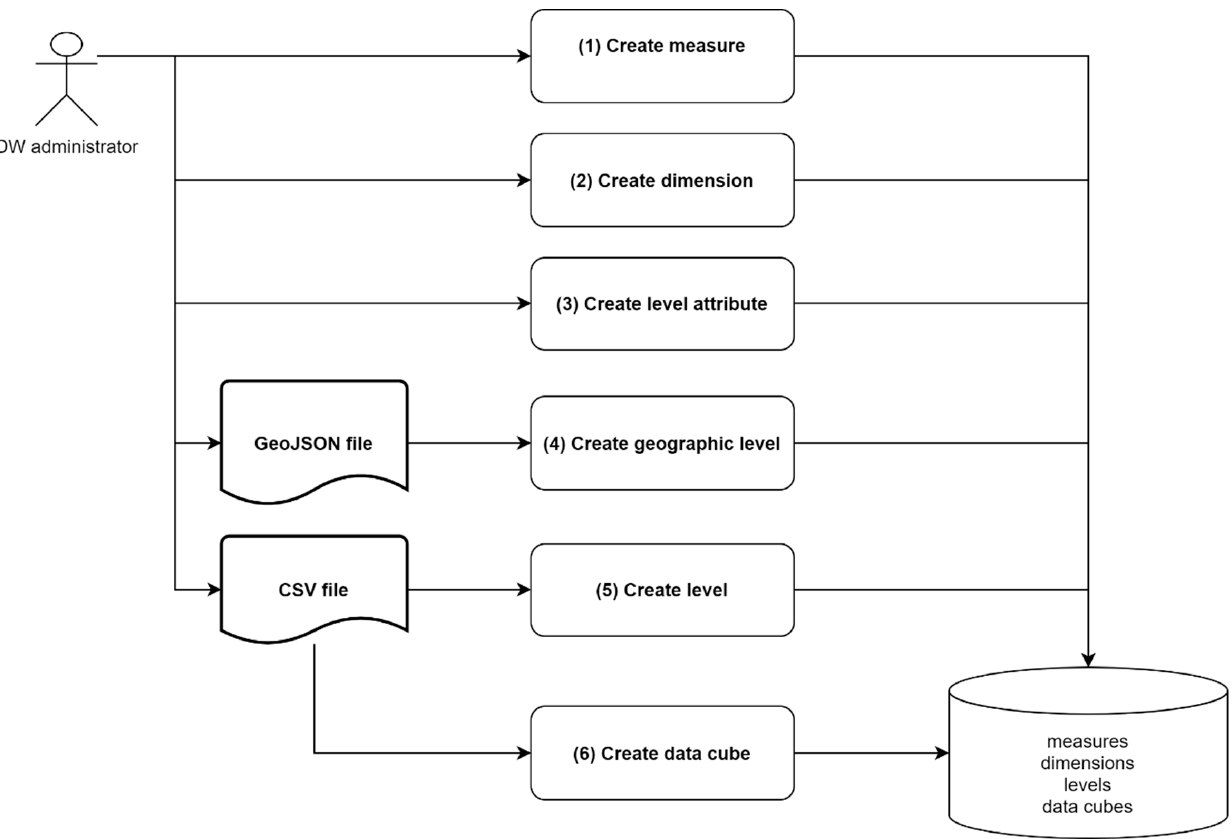
Figure 17 . Data integration workflow Figure 17. Data integration